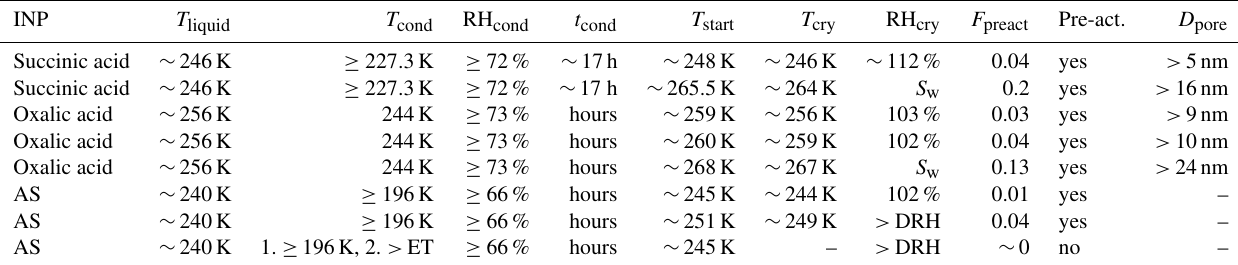
Table 10. AIDA chamber experiments by Wagner et al. (2014). T liquid – temperature of liquid cloud activation; T cond – conditioning tem- perature with respect to ice; RH cond – conditioning RH with respect to ice; t cond – conditioning time; T start – starting temperature of the expansion run; T cry – crystallization temperature of pre-activated particles; RH cry – crystallization RH with respect to ice; F preact – pre- activated fraction of particles; D pore – pore diameter needed to prevent ice from melting; AS – ammonium sulfate; DRH – deliquescence RH; ET – eutectic